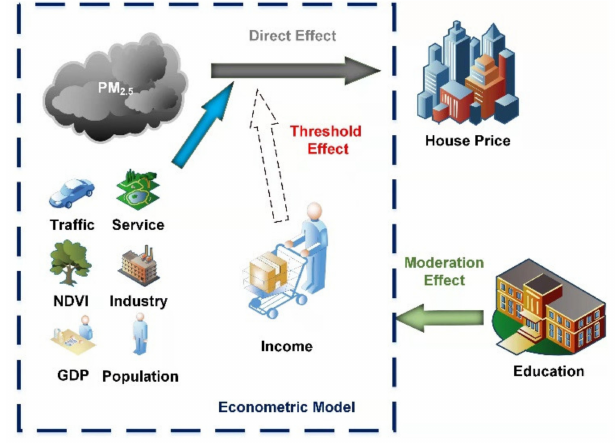
Figure 2. The analytical framework for the impact of PM 2.5 on house